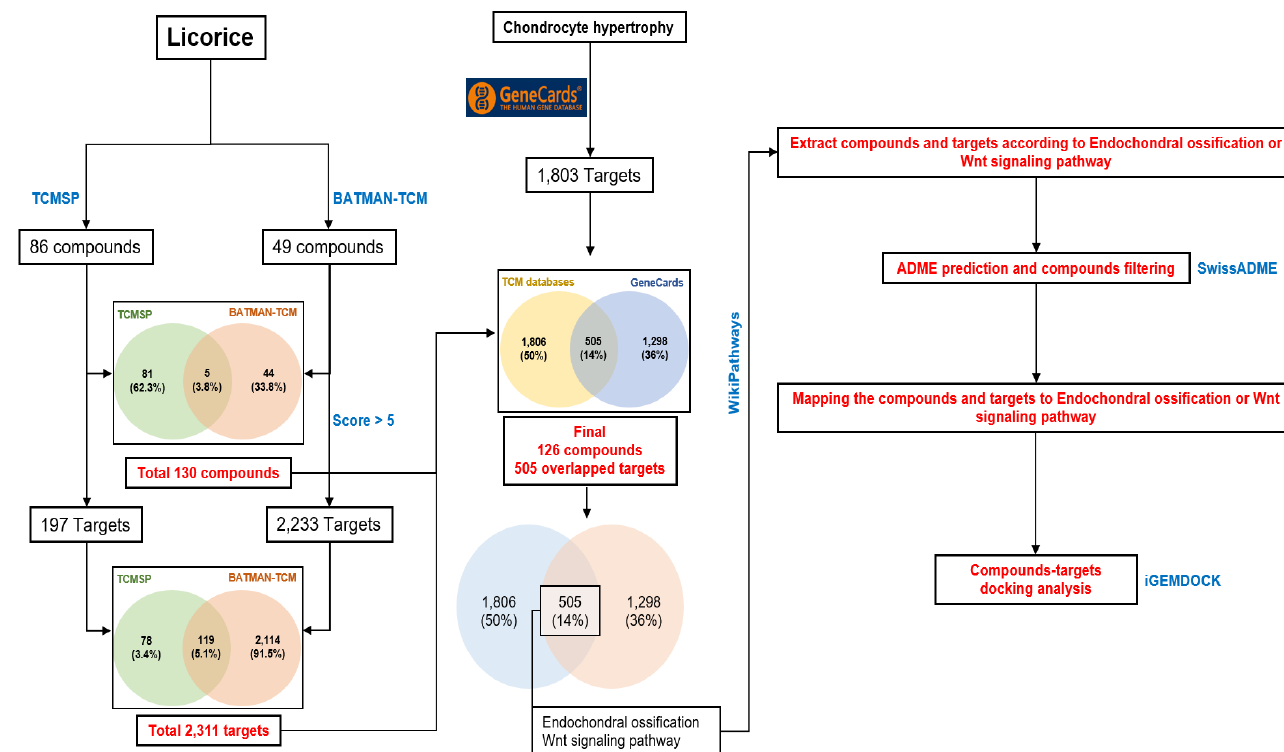
Figure 6. Flow work in silico pharmacology network analysis.